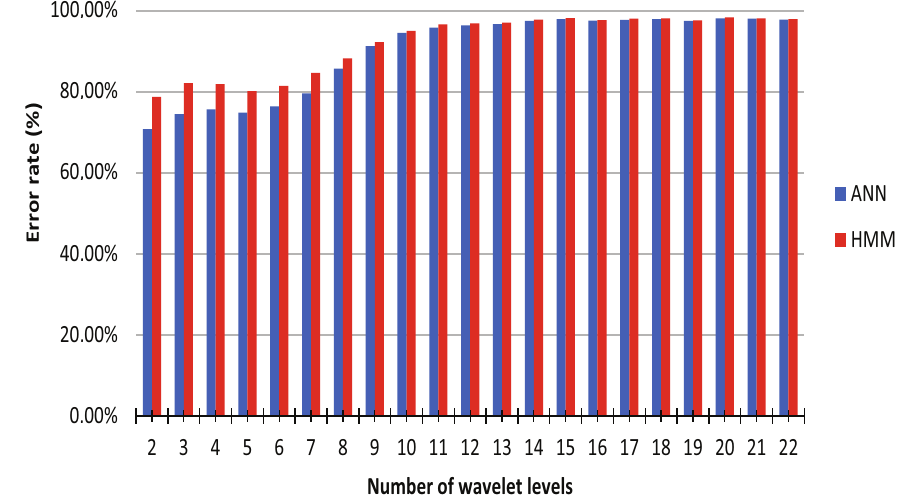
Figure 5. Average recognition rate of ANN (blue) and HMM (red) using cross validation and 25 nodes per layer for varying wavelet levels in the feature extraction.